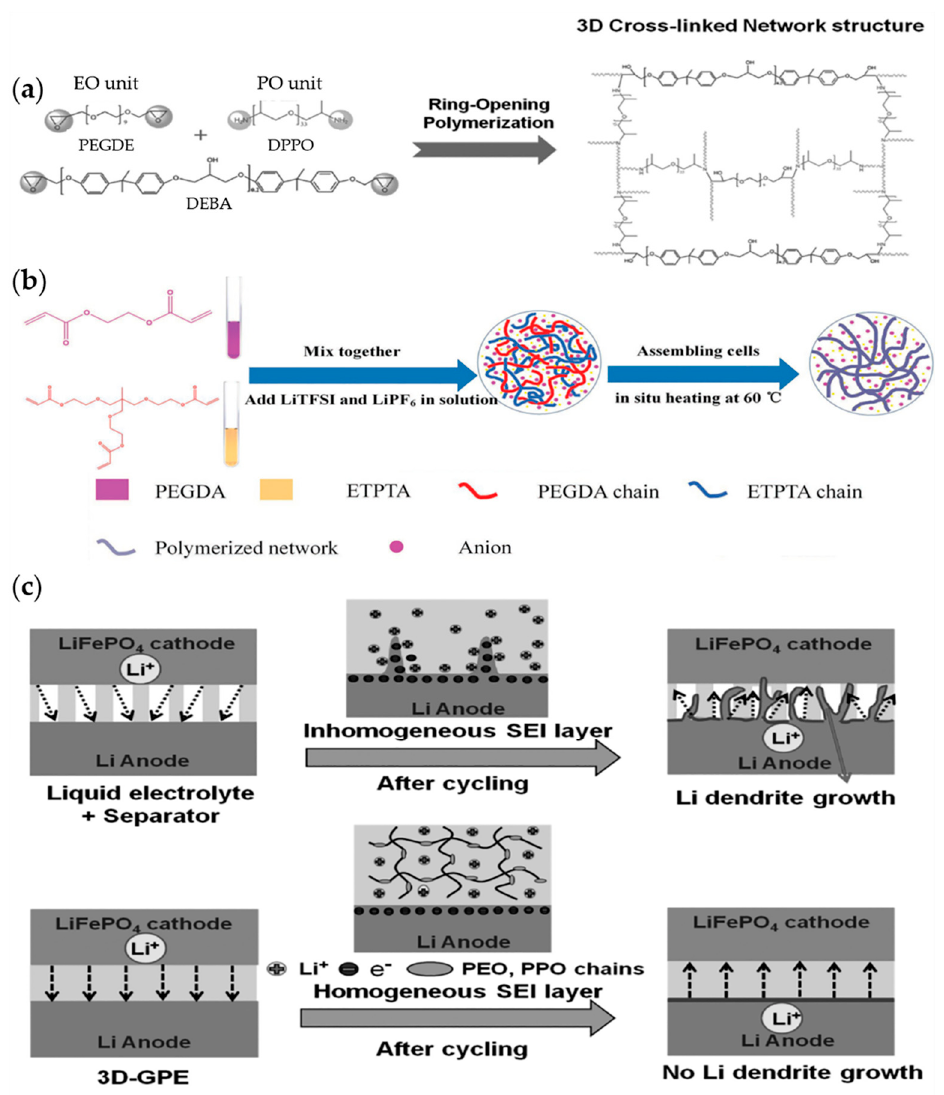
Figure 17. ( a ) Illustration of the synthesis of the GPE. Reprinted with permission from [148]. Copyright (2017) John Wiley and Sons. ( b ) Step process for in situ polymerization of GPE. Reprinted with permission from [162]. Copyright (2018) John Wiley and Sons. ( c ) Schematics of the changes in the Li electrodes using a liquid electrolyte and 3D-GPE during the Li plating / stripping. Reprinted with permission from [148]. Copyright (2017) John Wiley and Sons.